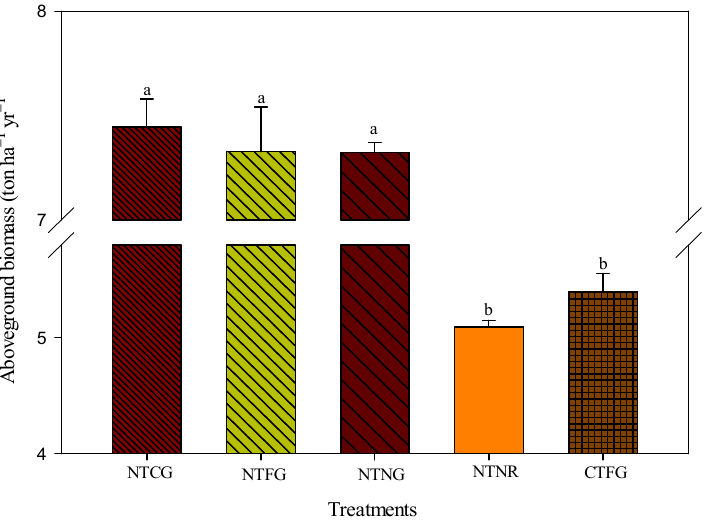
Figure 3. Aboveground dry biomass from conventional tillage with free grazing (CTFG), no-tillage with free grazing (NTFG), no-tillage with no grazing (NTNG), no-tillage with no residues (NTNR) and no-tillage with controlled grazing (NTCG). Error bars represent the standard error of the mean. N =